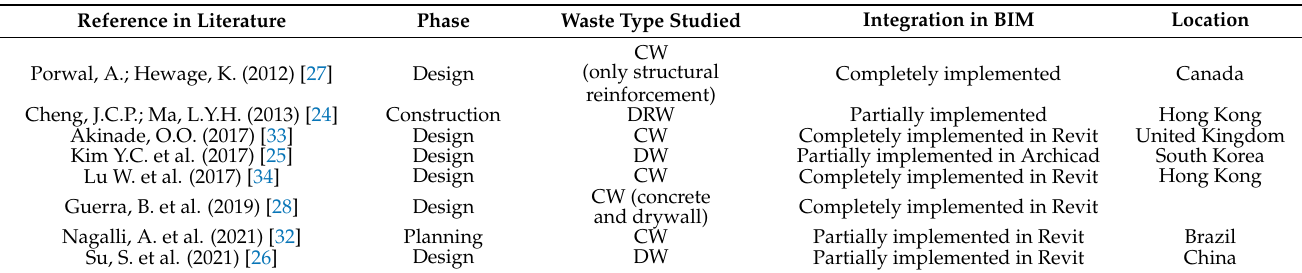
Table 1. Comparison between BIM-based tools in